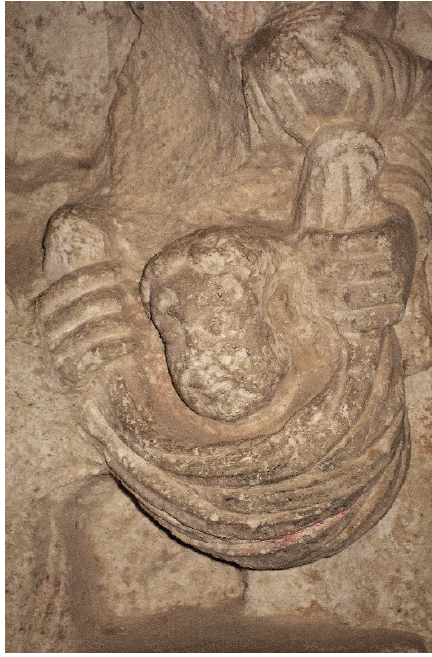
Figure 3. Almazán. Frontal (detail). Elevatio animae. Figure 3. Almaz á n. Frontal (detail). Elevatio animae.